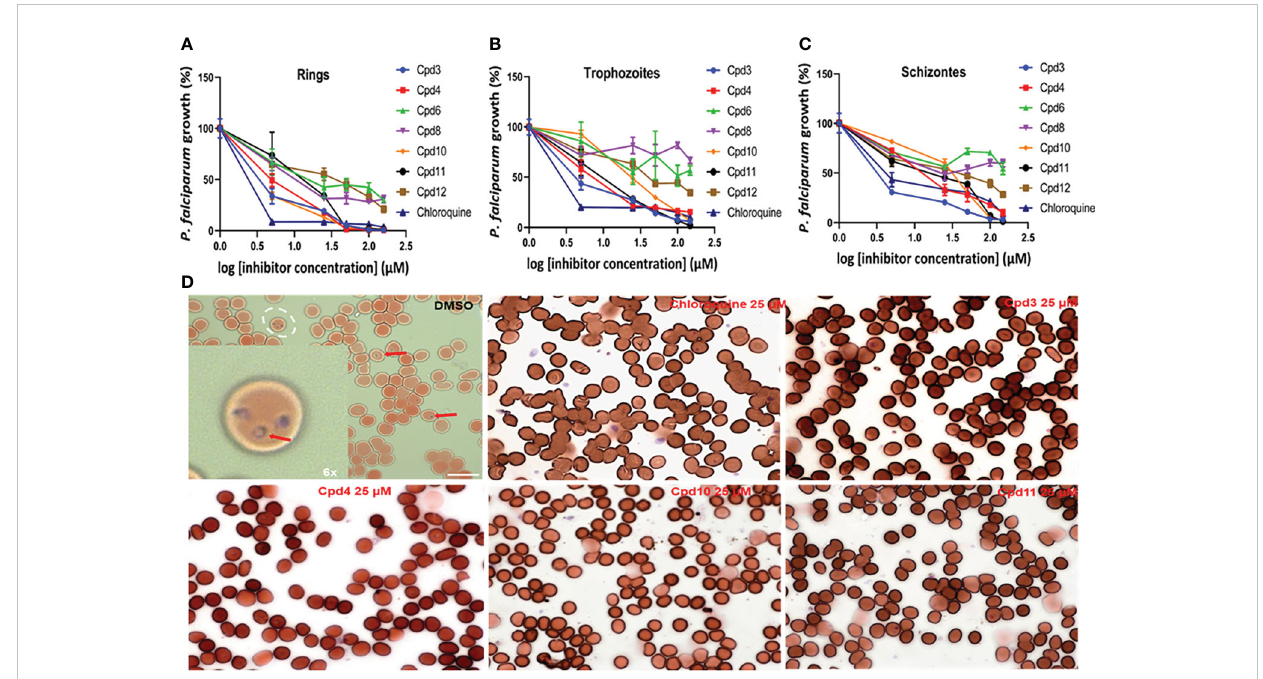
FIGURE 10 Dose-dependent inhibitory effects of the studied drugs on P. falciparum growth in red blood cells (RBCs). Panels (A – C) respectively showing ring stage, trophozoite and schizonte counts after drug treatments based on fl ow cytometry, with chloroquine as positive control (p < 0.0001). Panel (D) shows a blood smear used to visualize ring stages of the DMSO control versus selected drugs in all used